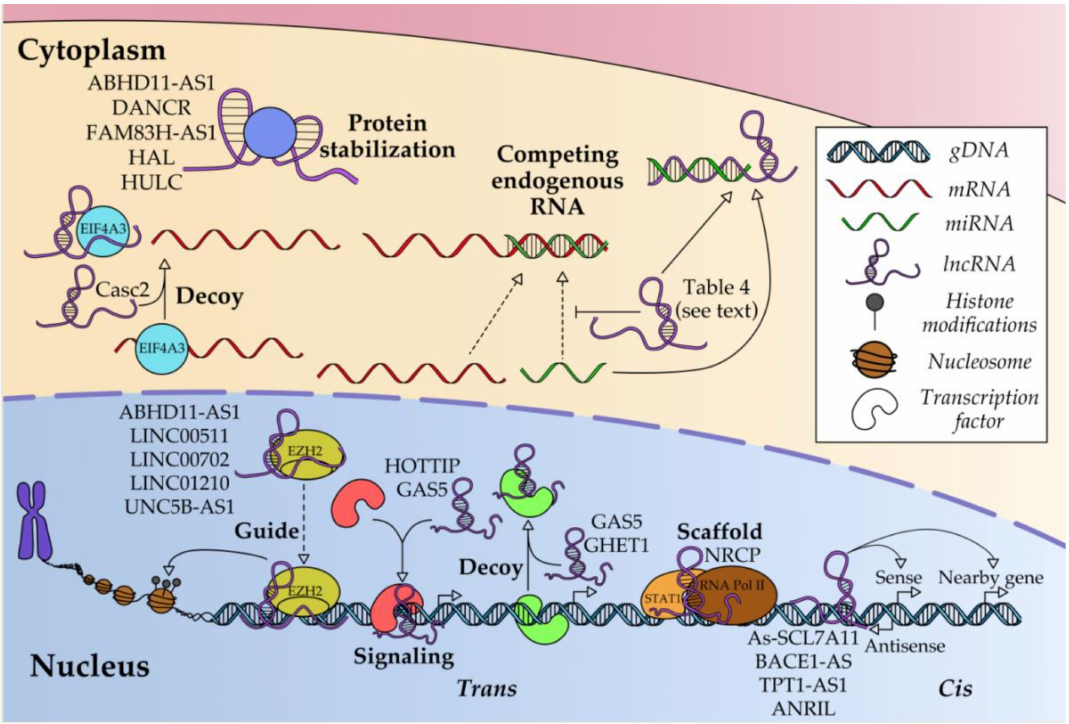
Figure 3. Scheme of di ff erent mechanisms by which lncRNAs control the expression of target genes in